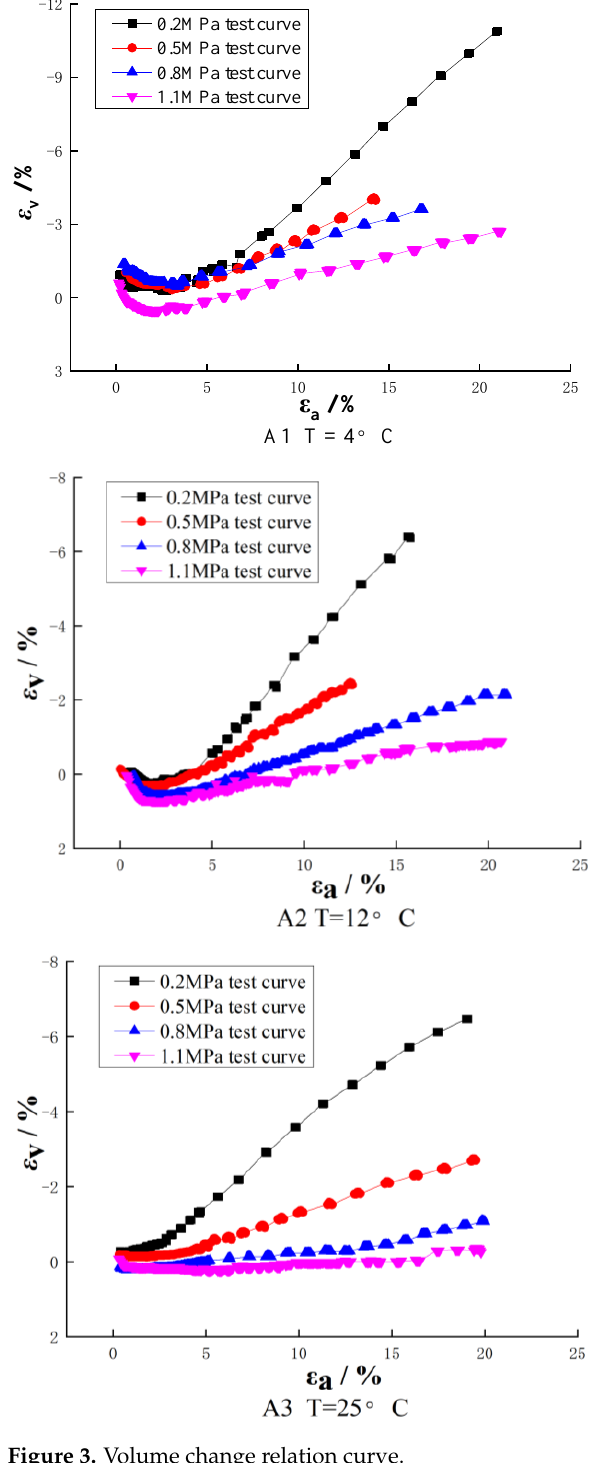
Figure 3. Volume change relation curve.